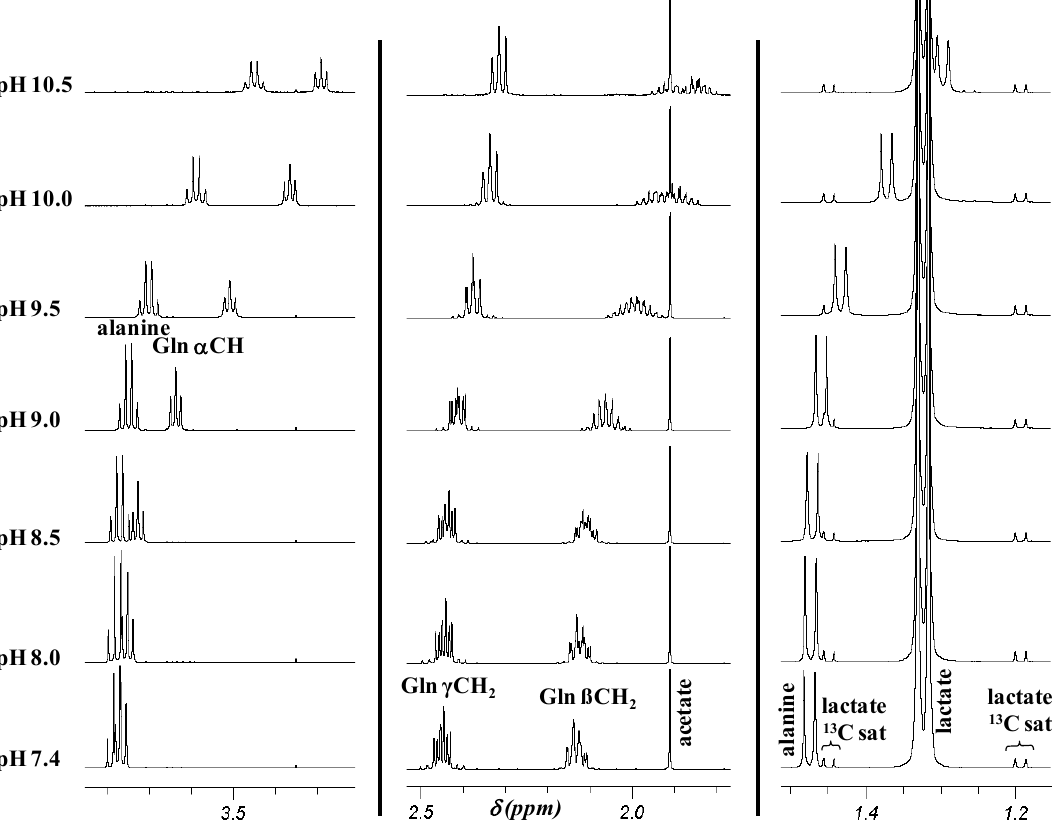
Figure 3. Partial 1 H NMR spectra (1.15–3.9 ppm region) of a model solution containing acetate, alanine, glutamine and lactate in D glutamine; sat: